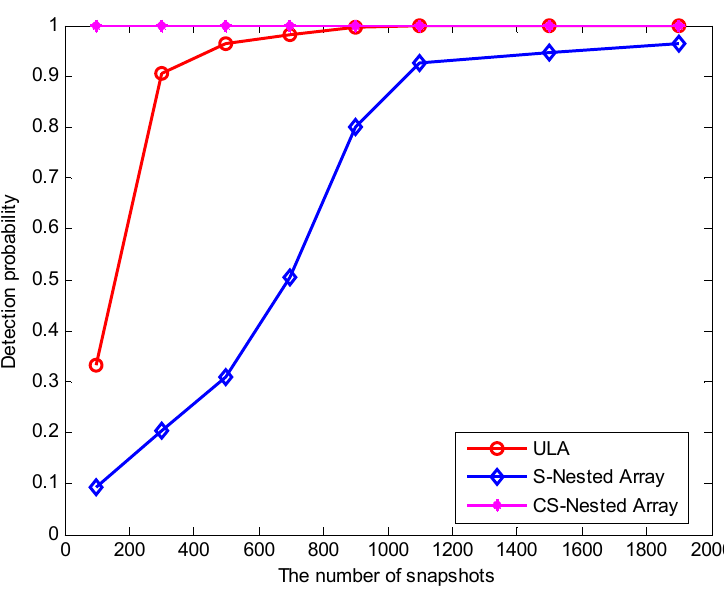
Figure 6. Detection probability versus total number of snapshots for the three methods.